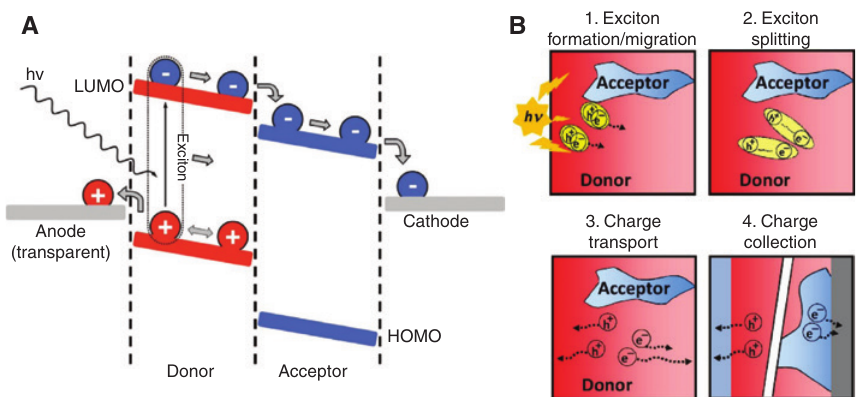
Figure 1: Device operating principle of